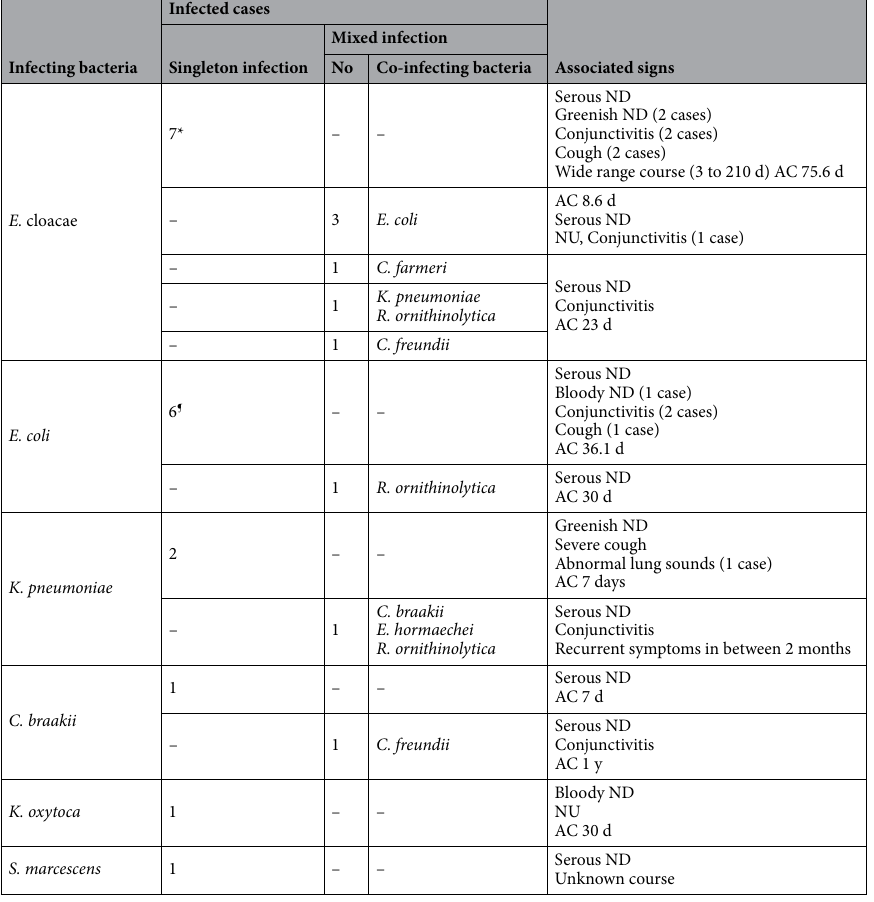
Table 2. Symptoms present in diseased dogs. ND nasal discharge, NU nasal ulcer, AC average course. *Two cases each were infected by two E. cloacae strains with different phenotypic and genotypic resistance patterns. ¶ Two cases each were infected by two E. coli strains with different phenotypic and genotypic resistance